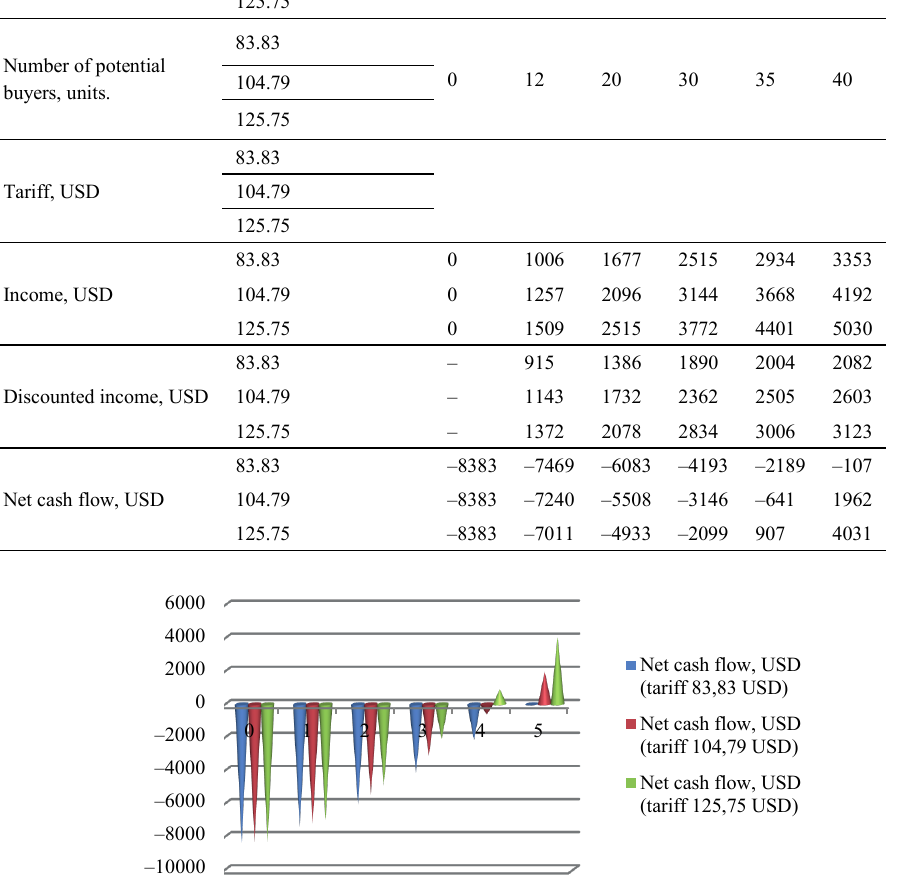
Fig. 8. Dynamics of net cash flow at various